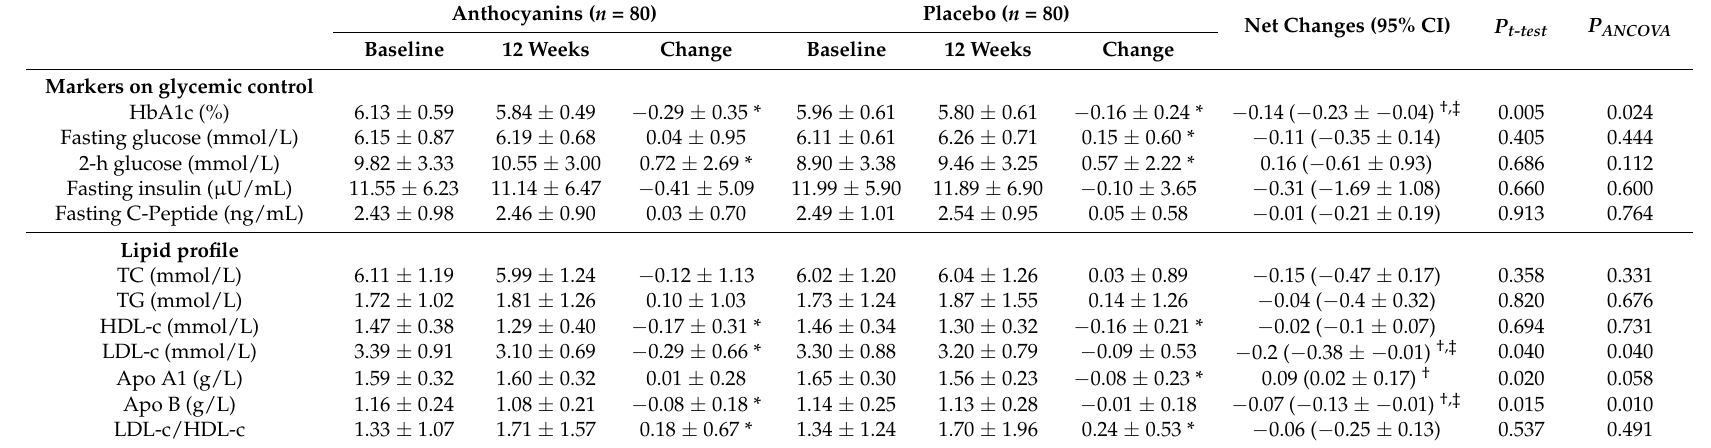
Table 2. Changes in markers of glycemic control and lipid profile after 12-week treatment by intention-to-treat analysis. Anthocyanins ( n = 80) Placebo ( n = 80)